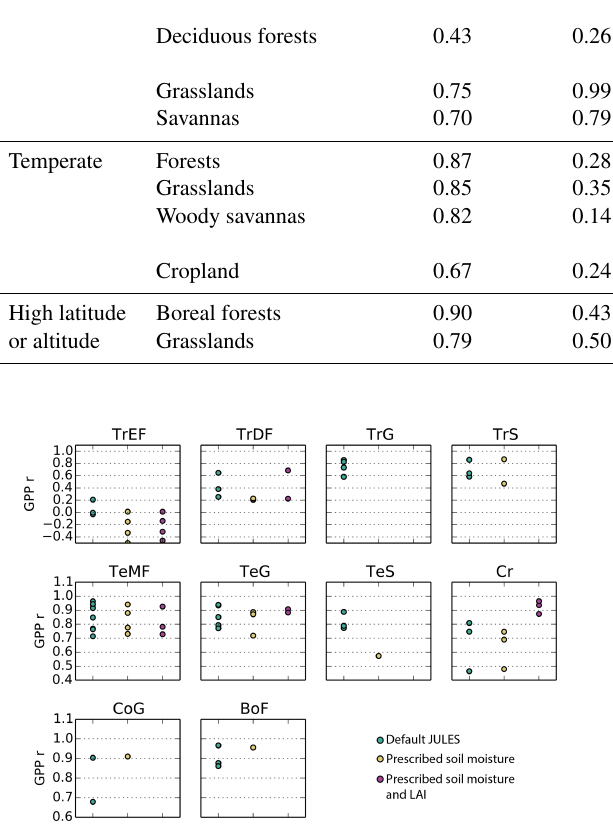
Figure 4. Correlation coefficient for simulated monthly mean GPP at Fluxnet sites for the following 10 biomes: TrEF stands for trop- ical evergreen forests, TrDF stands for tropical deciduous forests, TrG stands for tropical grasslands, TrS stands for tropical savannas, TeMF stands for temperate mixed forests, TeG stands for temperate grasslands, TeS stands for temperate savannas, Cr stands for crop- land, CoG stands for continental or high-altitude grasslands, and BoF stands for boreal forests. The sites that fall into each category are listed in the Supplement.